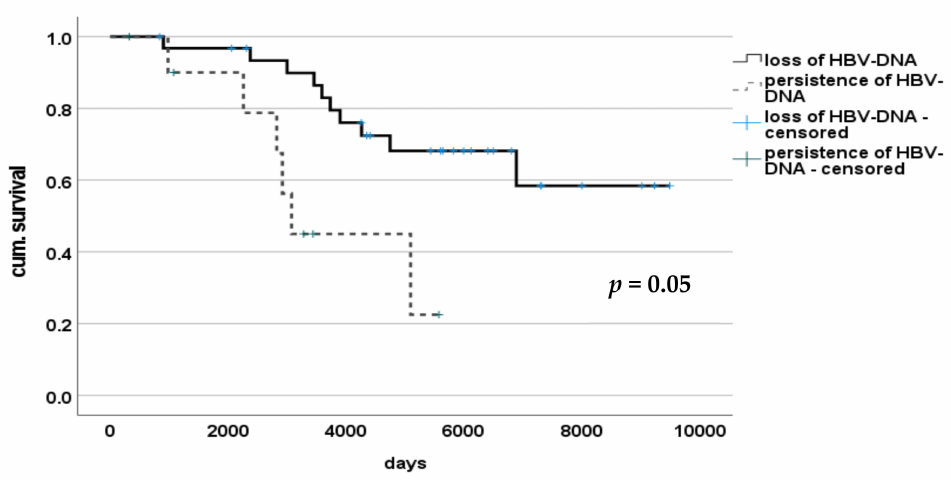
Figure 2. Survival of patients with or without de novo HBV-infection persistence after